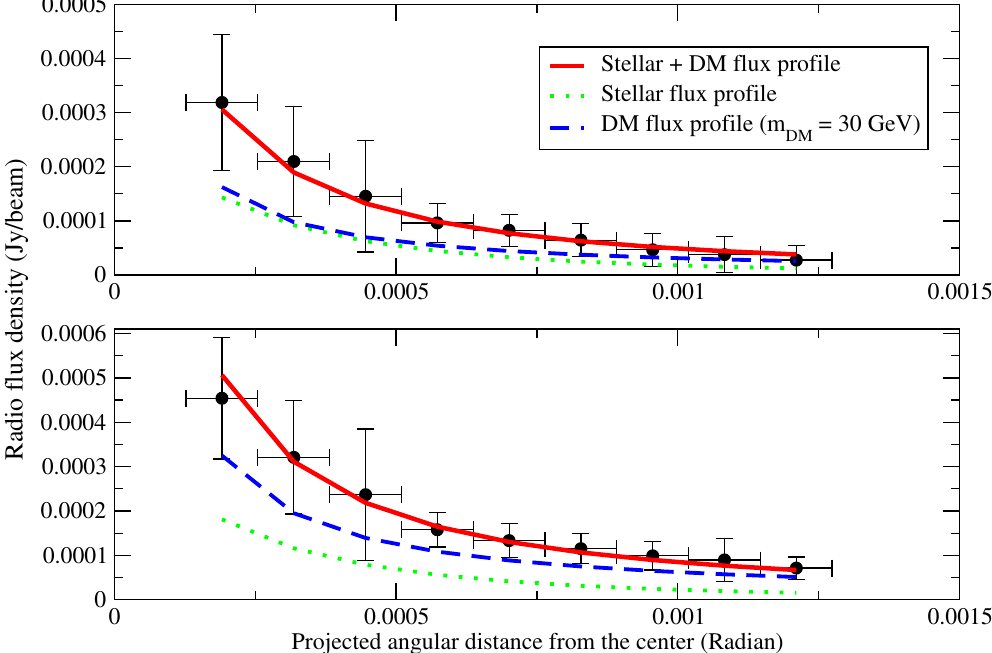
Figure 5. The best-fit thermal dark matter scenario for the radio emission profile of the M31 galaxy (assumed m DM = 30 GeV) [102]. The red solid line, green dotted line, and blue dashed line represent the total predicted radio flux profile S ( θ ) , the stellar flux contribution, and the dark matter contribution, respectively (upper: 8.35 GHz; lower: 4.85 GHz). The radio data were extracted from